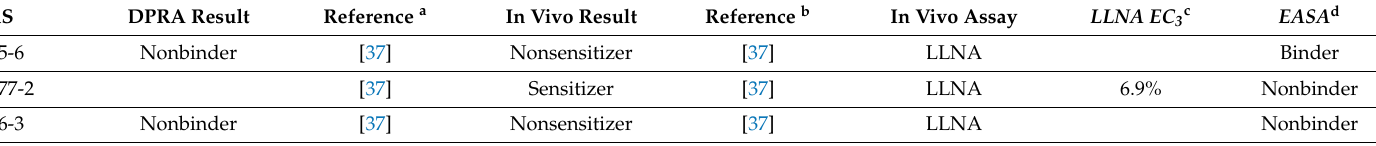
Table 1. Description of test chemicals including results from other studies and overall EASA